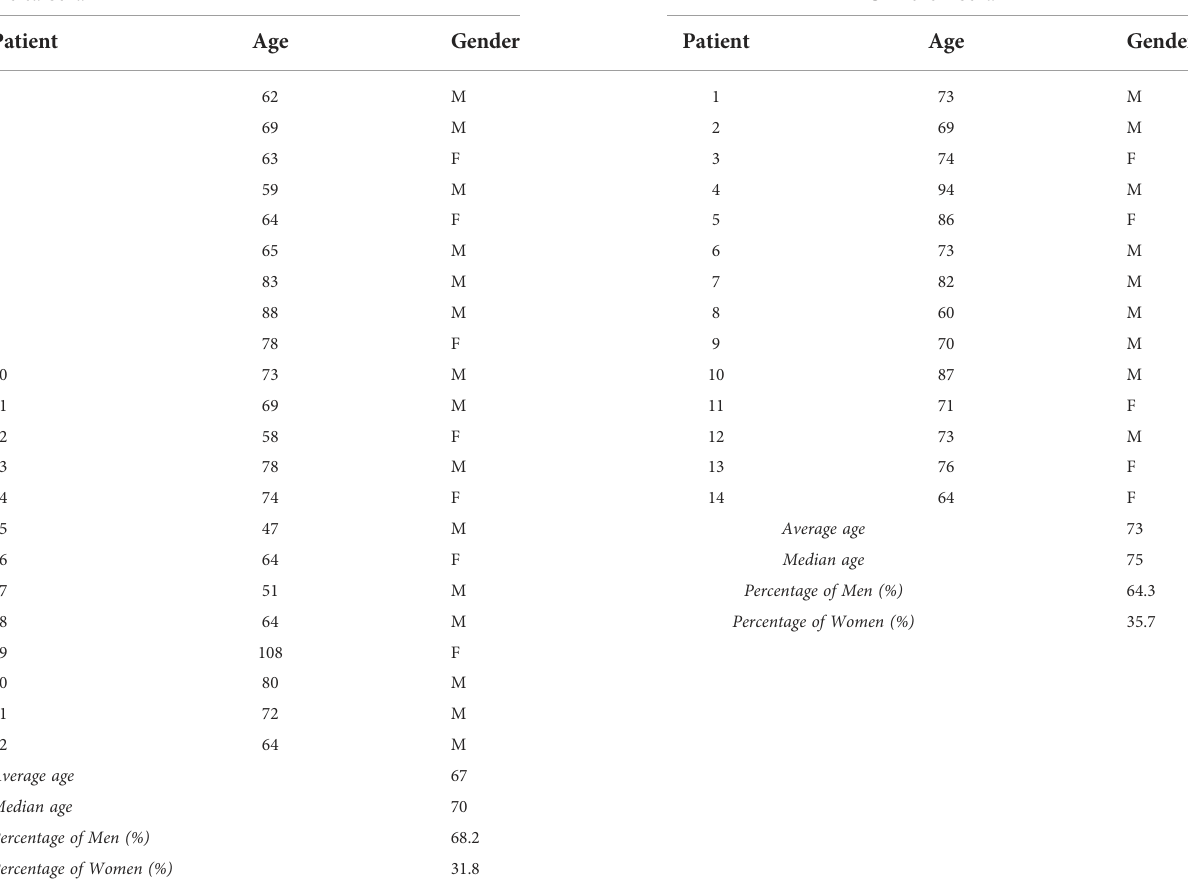
TABLE 1 Patients sera: These table contain age and gender of patients used to Netosis assay. Delta